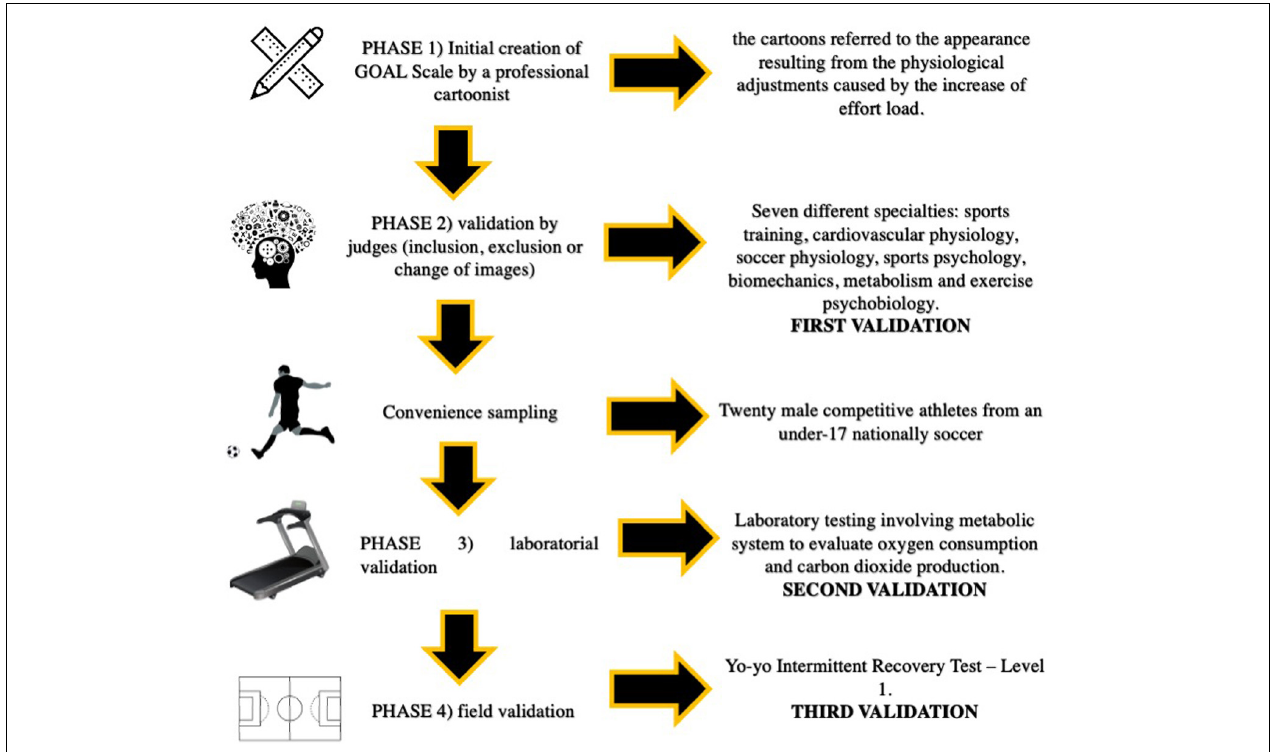
FIGURE 1 | Schematic figure of the experimental